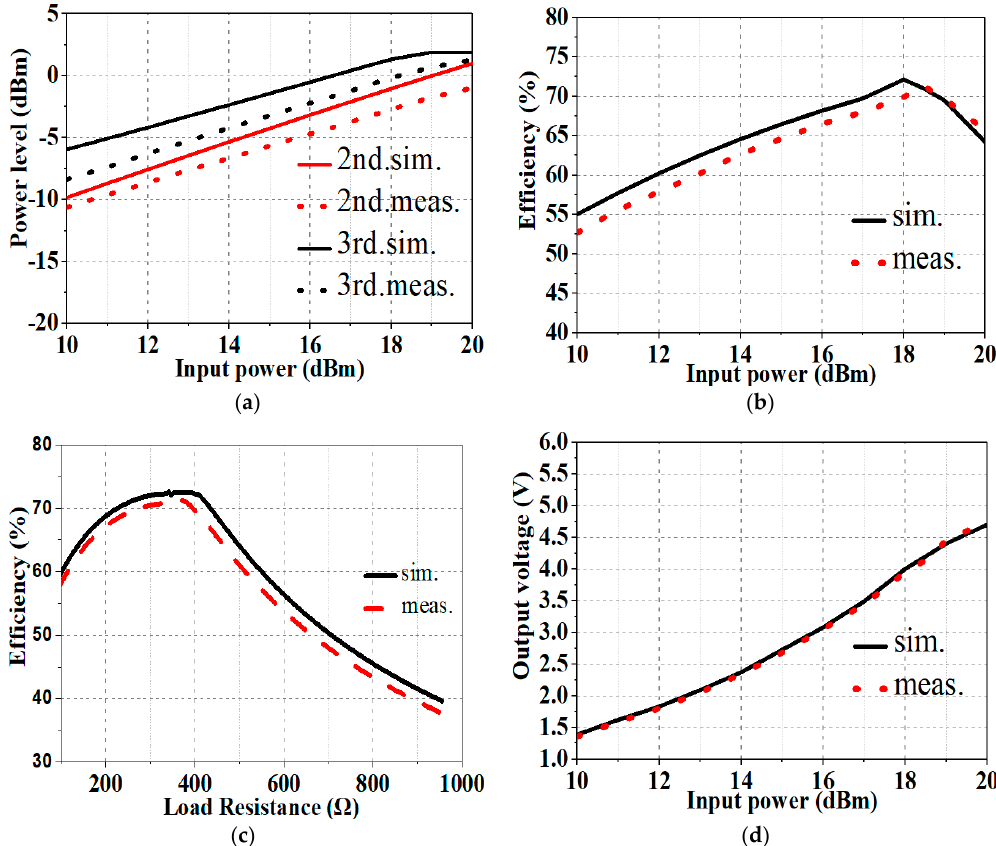
Figure 7. The measured and simulated result of the rectifier utilizing the 2nd and 3rd harmonics: ( a ) the measured and simulated harmonic amplitude varies with input power; ( b ) the measured and simulated rectifying efficiency varies with input power; ( c ) the measured and simulated rectifying efficiency varies with the load; ( d ) the measured and simulated output voltage varies with input power.